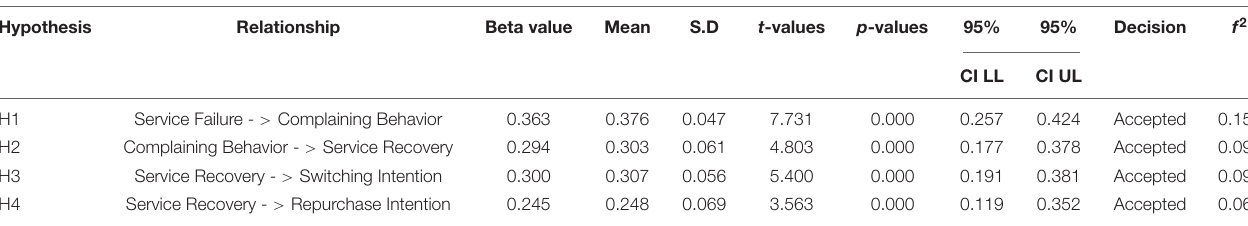
TABLE 6 | Hypotheses